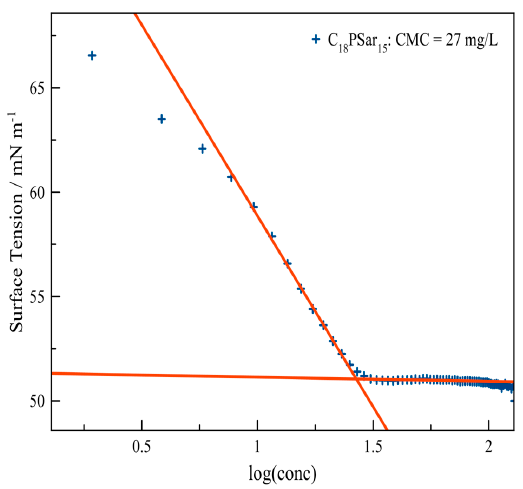
Figure 2. Exemplary CMC measurement shown for C 18 PSar 15 . CMC was determined by ring tensiometry. Intersection of the two lines represents the CMC value.